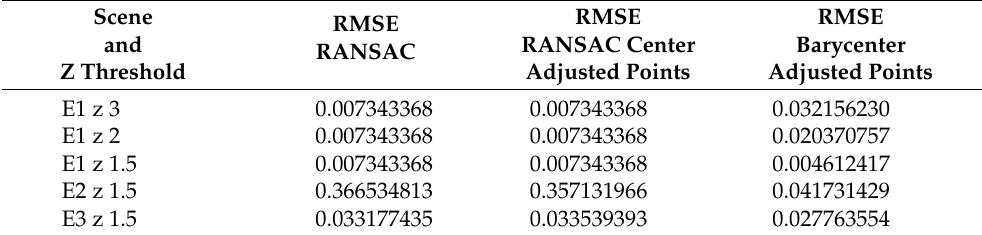
Table 2. RMSE centers detected with RANSAC adjusted with Z